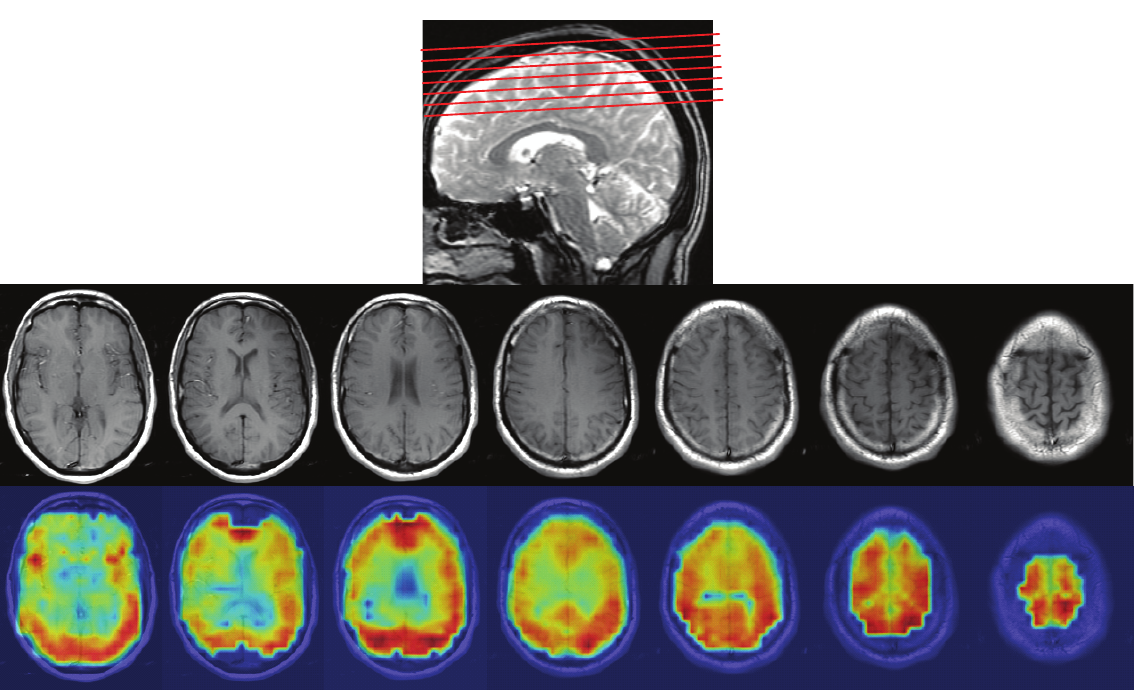
Figure 5: Slice prescription (top), localizer images (middle), and NAA images overlaid on localizers (bottom). The slices are contiguous and cover a large volume of the